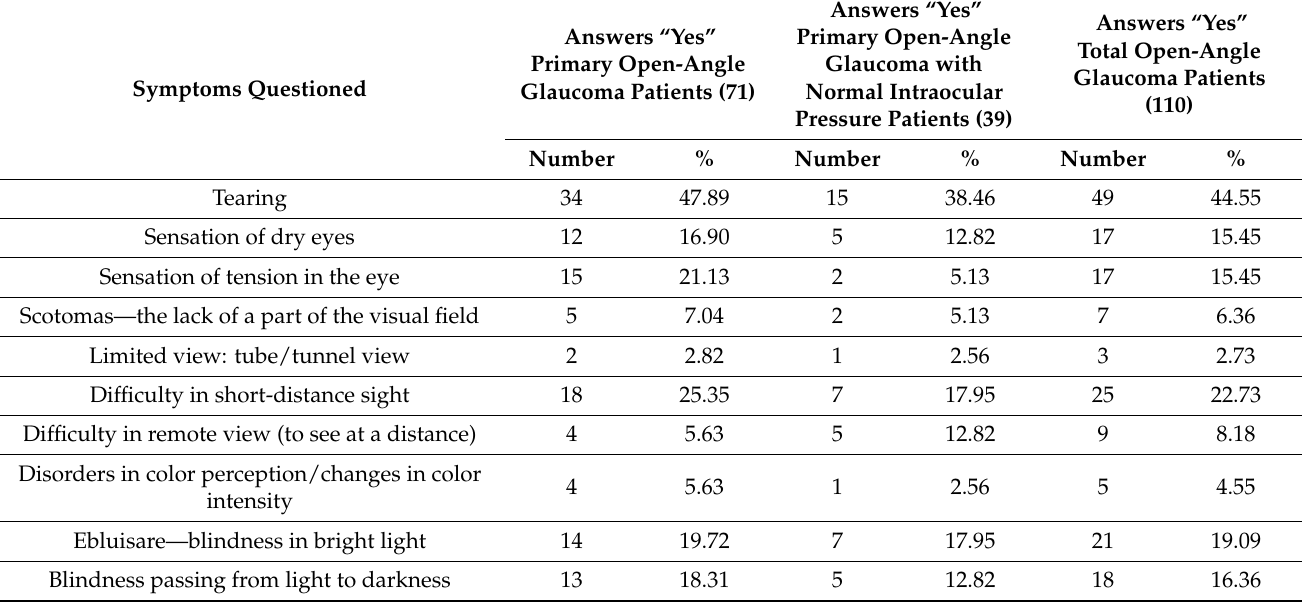
Table 11. Distribution of affirmative responses to “Symptom Inventory” questionnaire in POAG and NTG patients.